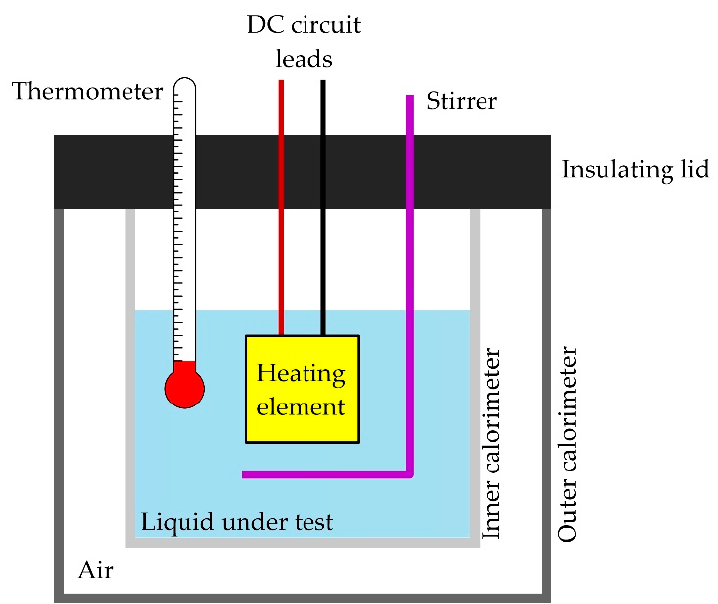
Figure 4. Schematic diagram of the calorimeter.